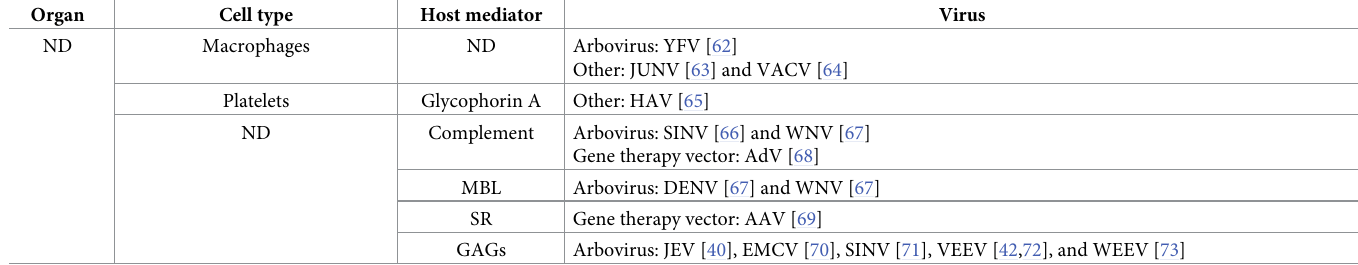
particulates to the space of Disse and the underlying hepatocytes. LSECs have high clathrin- mediated endocytic capacity. Most often associated with pinocytosis of particles smaller than 200 nm [96–101], LSECs also are capable of phagocytosing larger latex beads following impairment of KC function [102].